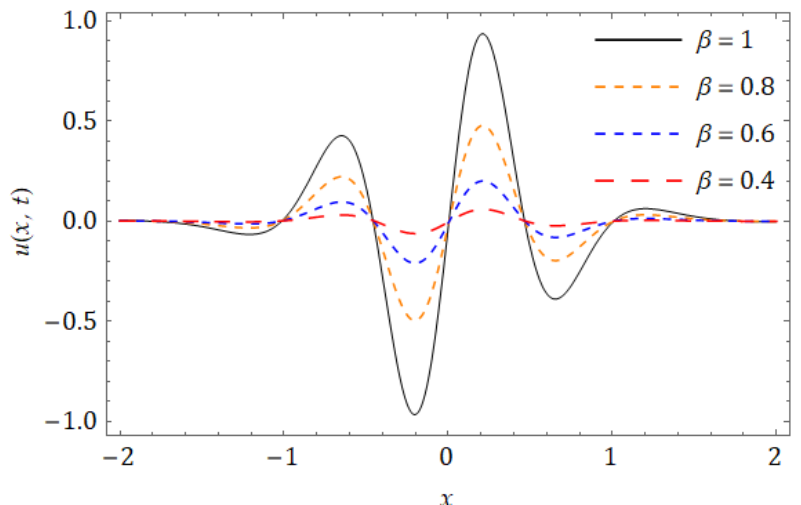
Figure 3. Response of the obtained solution with distinct 𝛽 and time at 𝑛 = 1, 𝑡 = 0.5, ℏ = −1, 𝛼 = 1, 𝑐 = −1, 𝜅 1 = 1 and 𝜌 = 0.001 for Case I.